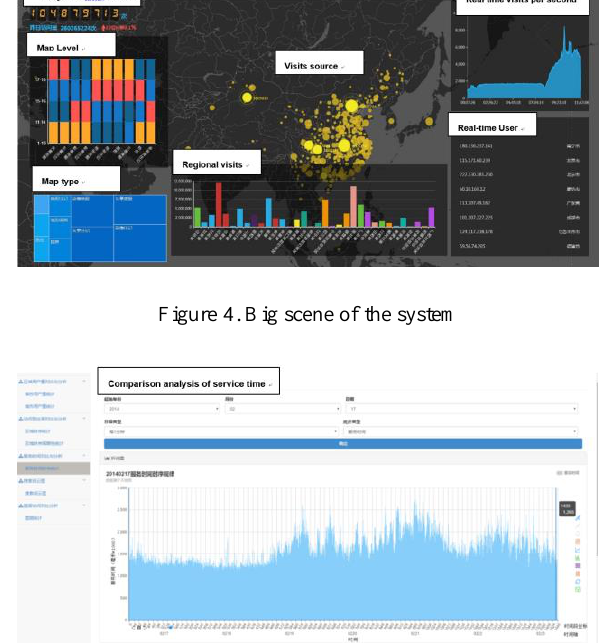
Figure 5. Monitor website of the